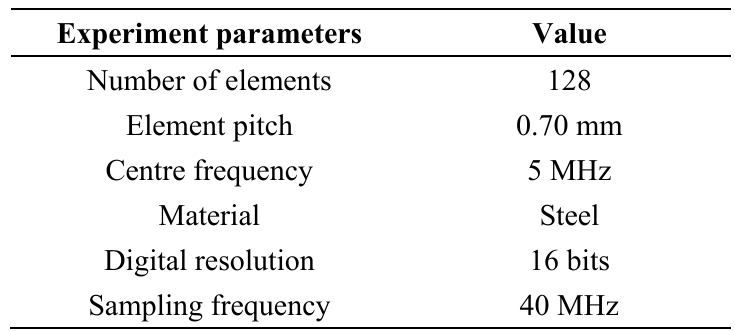
Table 2. Experiment